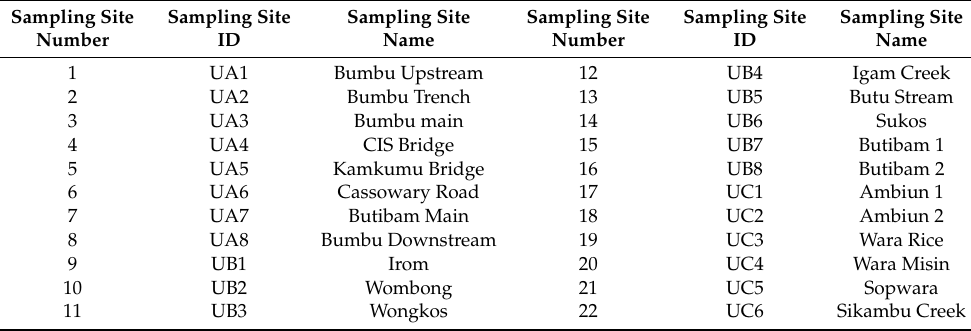
Table 1. Water sampling points and the names of the respective sites.